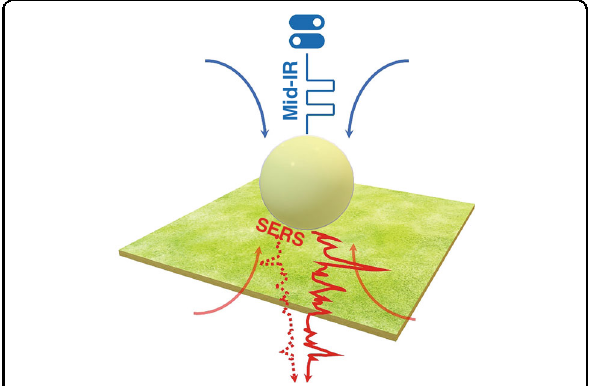
Fig. 1 Plasmonic nanocavity for mid-IR perturbation. Schematic illustration to trigger the SERS signal from a nanocavity using a mid-IR perturbation